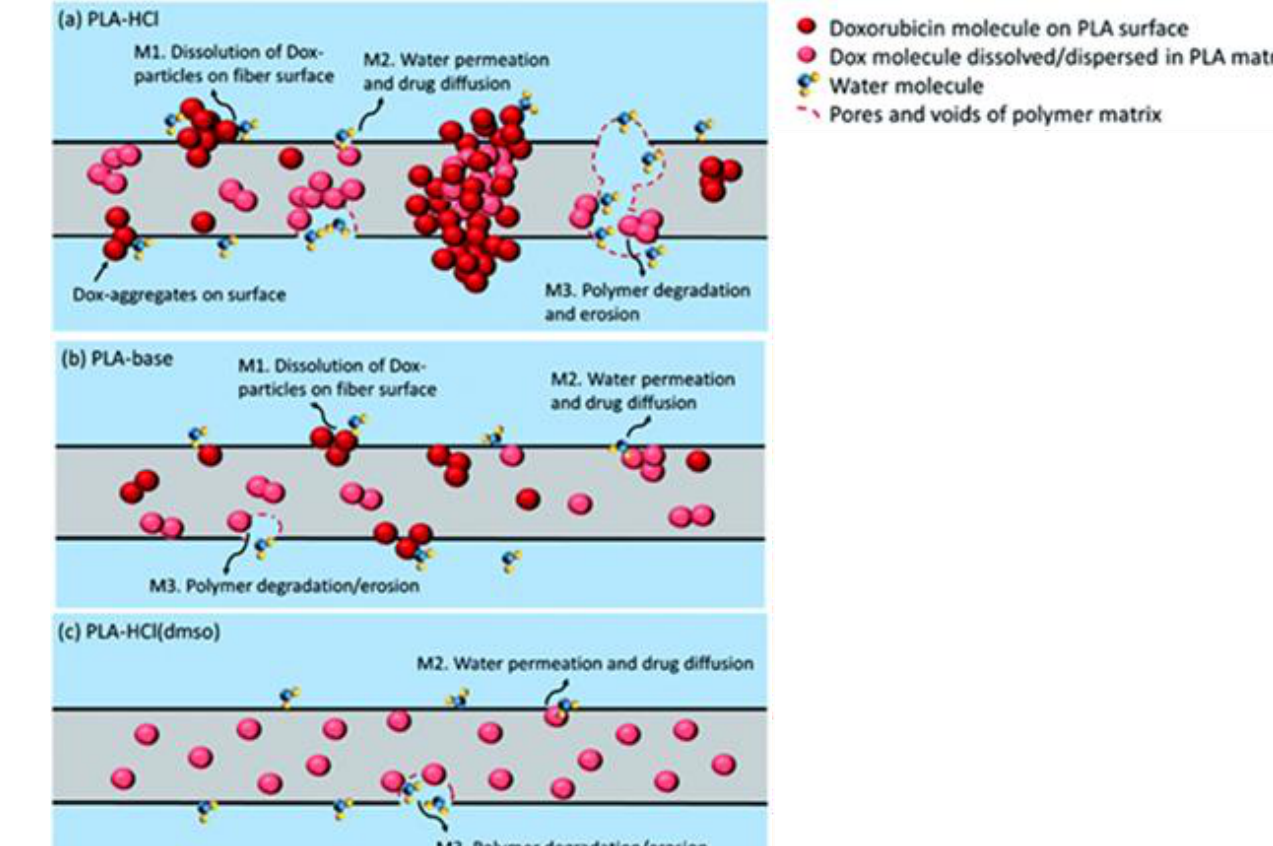
Figure 13. The scheme image of the different methods for loading the drug in nanofibers, repro- duced from an open access paper, [71], under the terms of Creative Commons Attribution 4.0 In- ternational (CC BY 4.0) License.